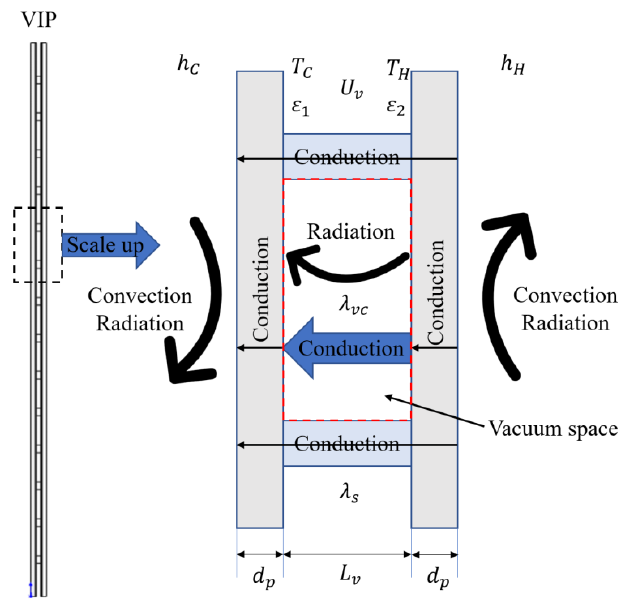
Figure 7. Schematic of heat transfer through a double plate unit.